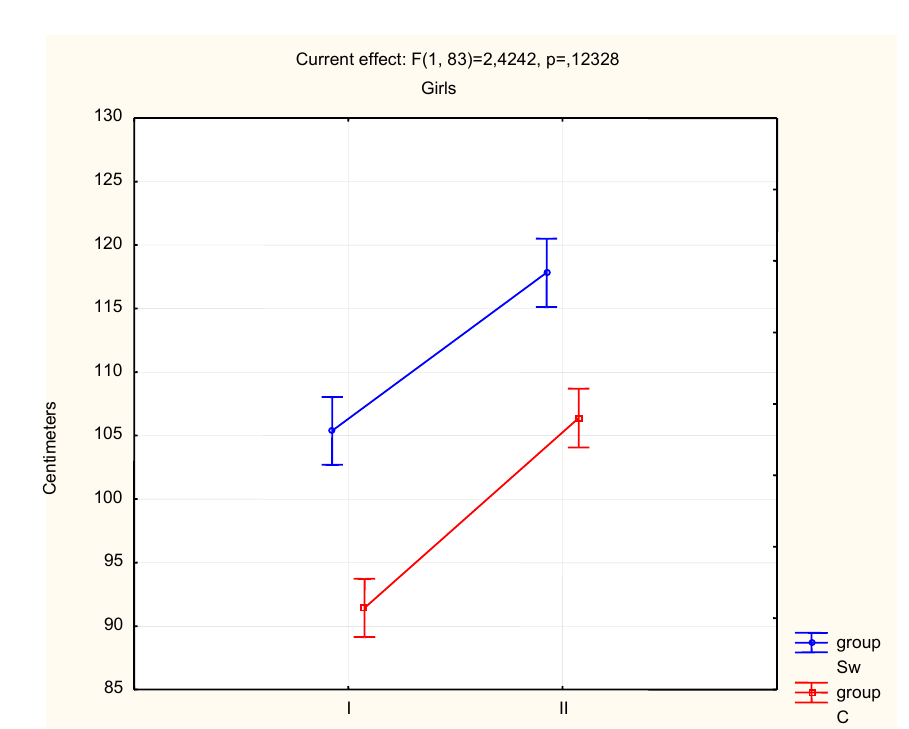
Fig 4. Changes of Standing Broad Jump Test (explosive leg power) results in the Swimmers (Sw) group and Control (C) group